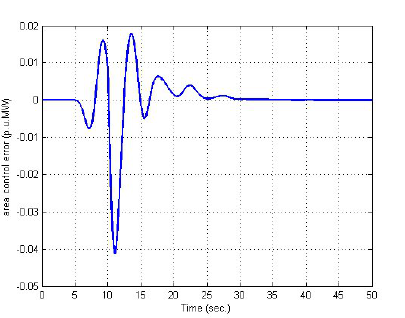
system are the same with Case